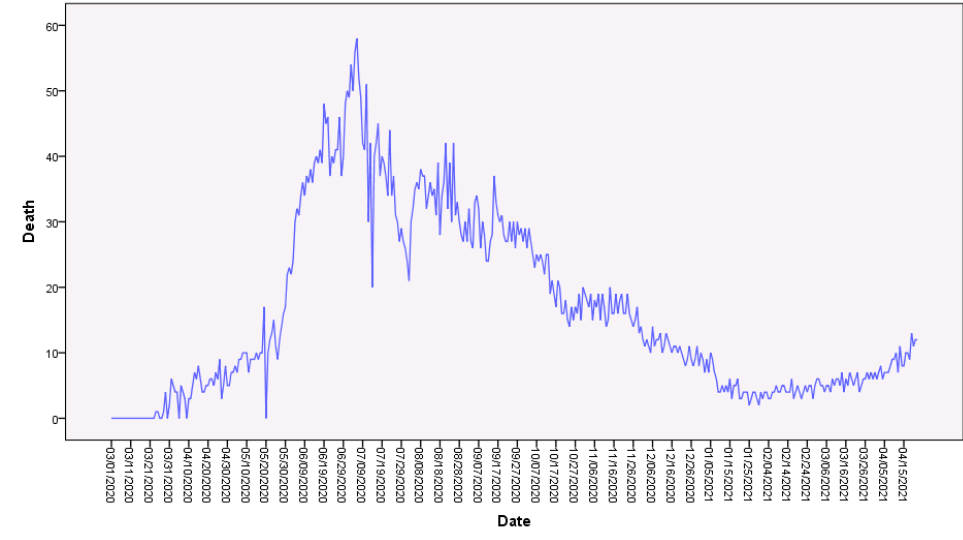
Figure 2. Death cases of COVID-19 in Saudi Arabia for the period from 1 March 2020 to 22 April